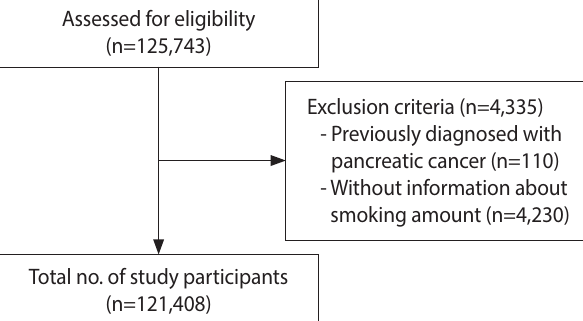
Figure 1. Flow chart of enrolled